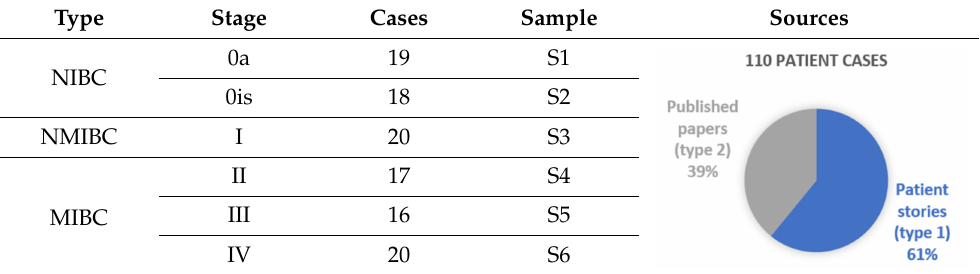
Table 8. BC sample cases distributed according to treatment and BC stage.